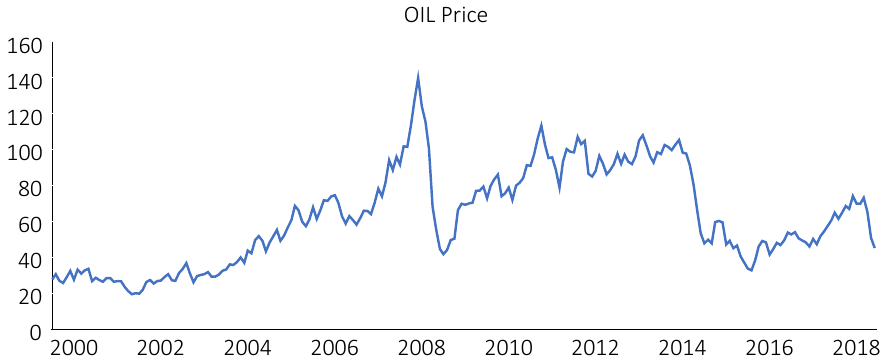
Figure 4. International oil price per barrel in US dollars during